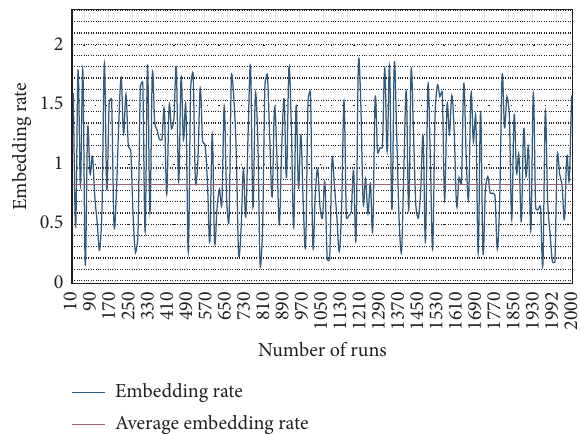
Figure 5: Schematic diagram of secret information embedding rate results with a length of 20 words.